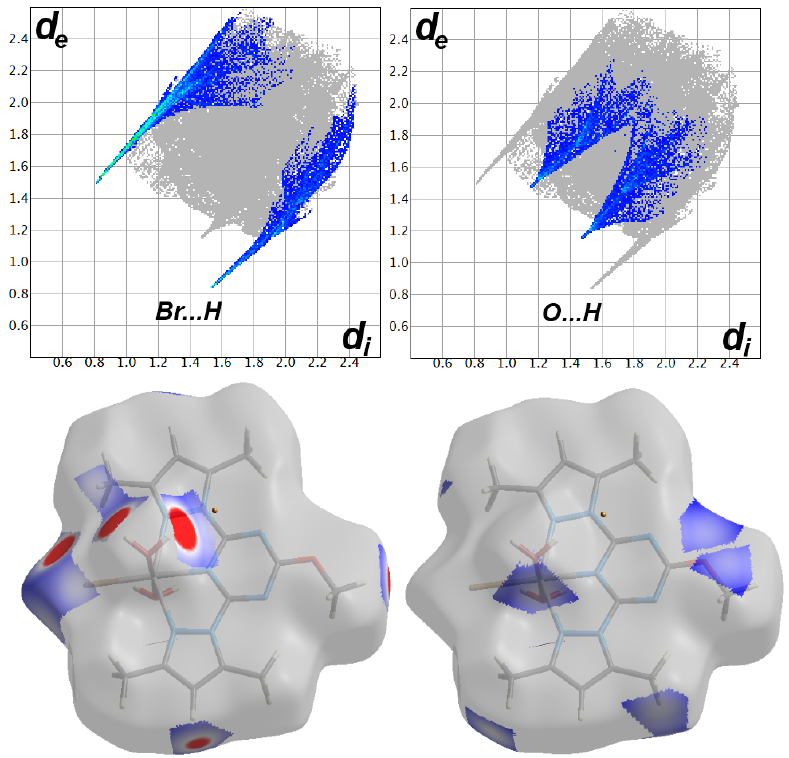
Figure 5. The decomposed d norm and fingerprint plots of the Br…H and O…H interactions in the [Co(L)(H 2 O) 2 Br]Br complex.